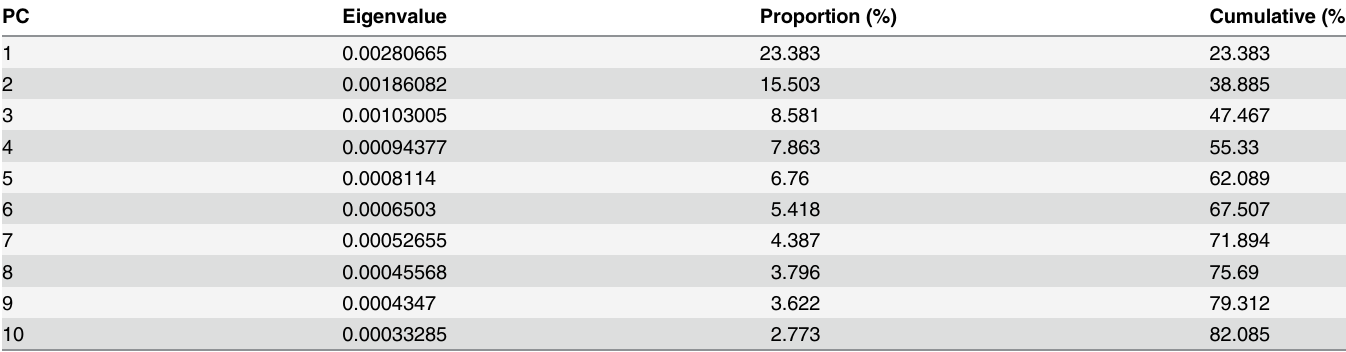
Table 3. Eigenvalues and explanatory proportion for the first 10 principal components (PCs) from the principal component